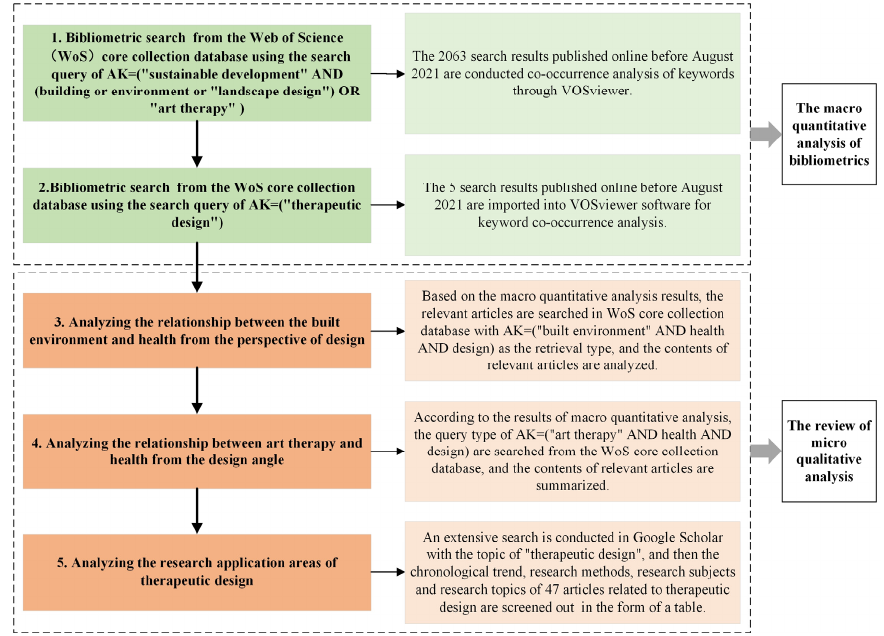
Figure 1. The flow chart of the research methodology.